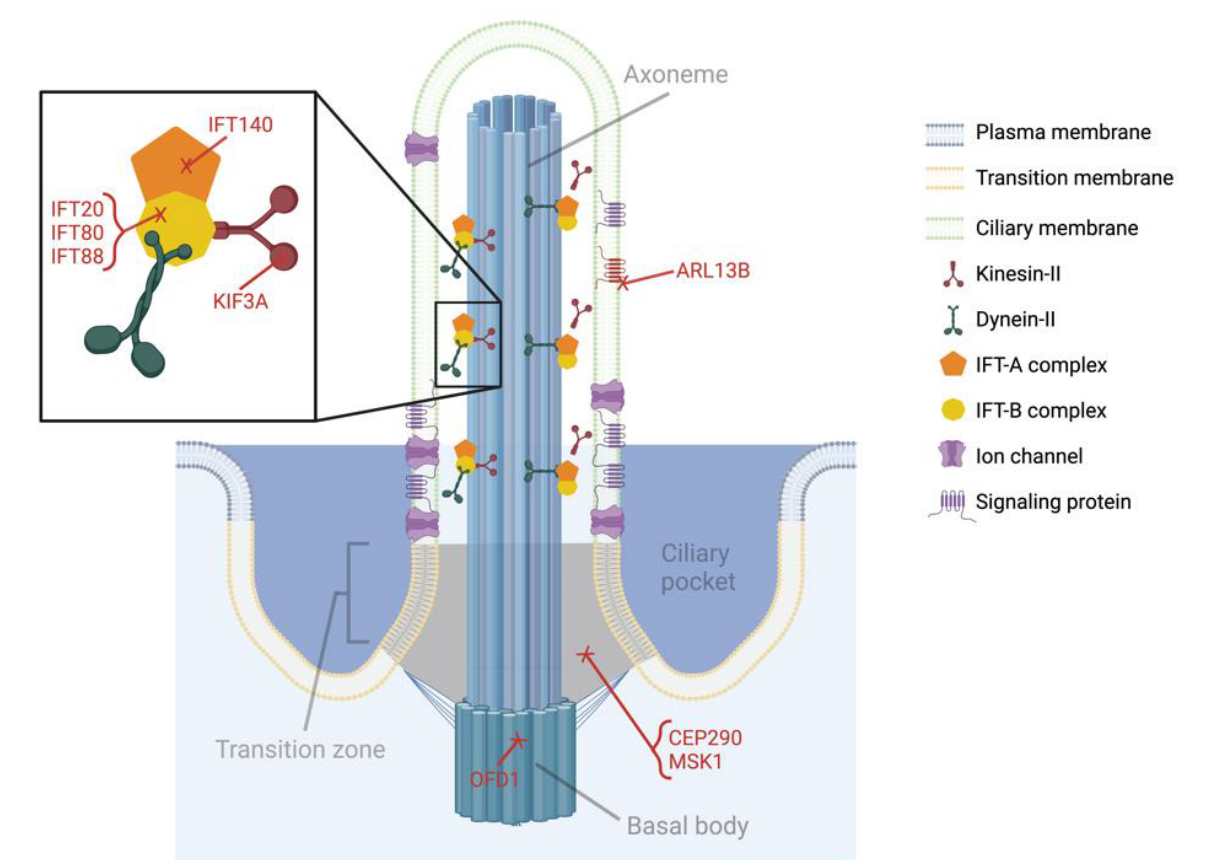
Figure 3. Primary cilium components associated with proteins linked to craniofacial abnormalities. Primary cilia function can be disrupted by altering a variety of components within the ciliary com- plex. Loss of KIF3A renders the motor protein kinesin-II non-functional. Removal of IFT proteins such as IFT20, 80, 88, and 140 alters the activity of IFT-A and IFT-B complexes, as well as their ability to bind motor proteins. Protein trafficking and localization are disrupted with mutations in proteins located in the ciliary membrane (ARL13B) or the transition zone (CEP20 and MSK1). The axoneme is unable to form normally when the basal body is destabilized from loss of proteins such as OFD1. This figure was created with BioRender.com (accessed on 14 November 2022) .